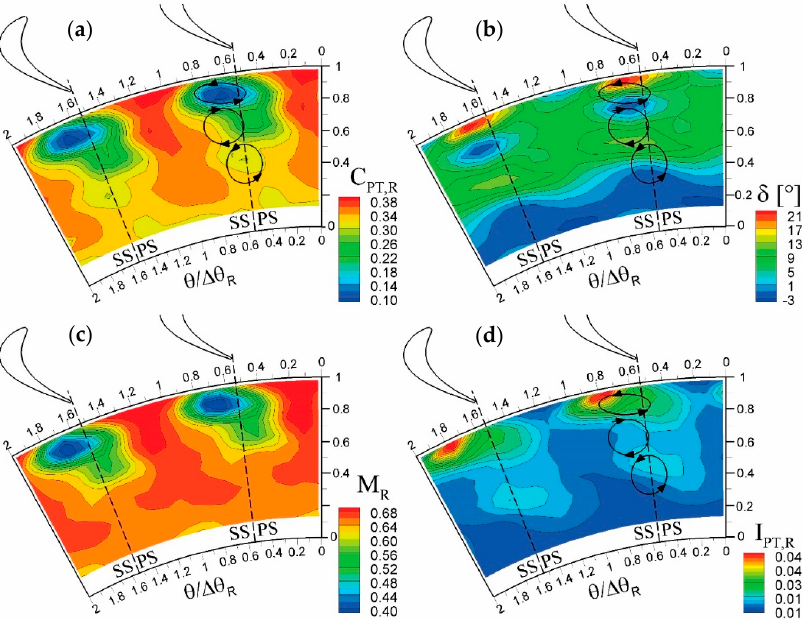
Figure 7. Rotor-exit relative flow field in OP1 (transonic), ( a ) relative total pressure coefficient; ( b ) deviation angle; ( c ) relative Mach number; ( d ) unresolved unsteadiness.